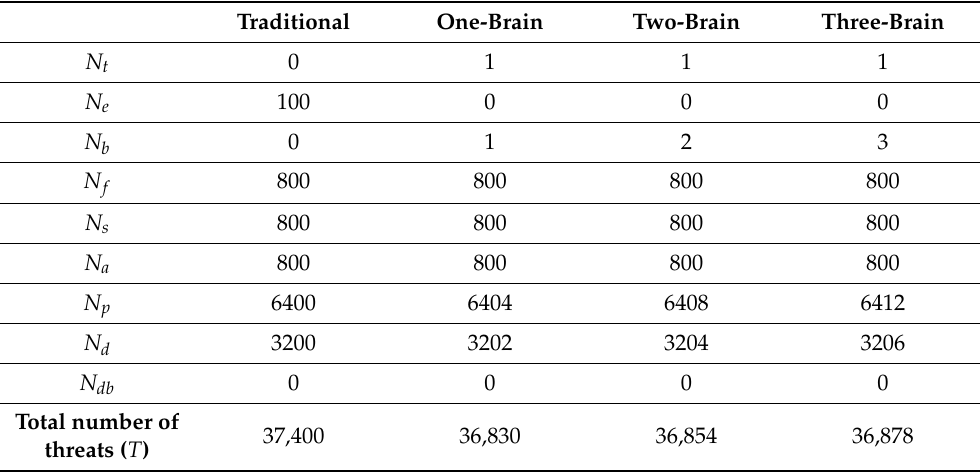
Table 1. Comparison of Number of Cybersecurity Threats in the Traditional and Brain-based Architectures. Traditional One-Brain Two-Brain